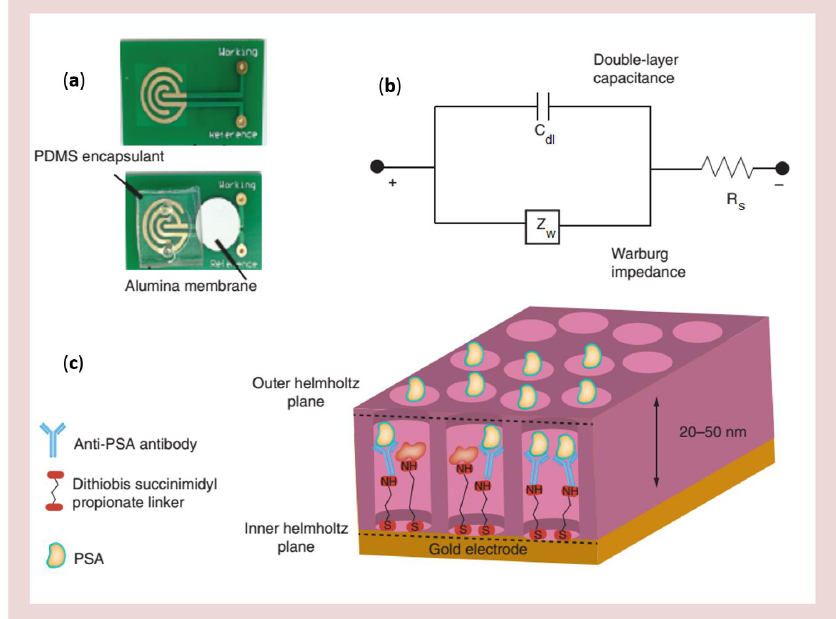
Figure 14. Electrical nanowell biosensor design, assembly and operation. Sensor device and operation ( a ) optical micrograph showing the gold microelectrodes, PDMS encapsulant and nanoporous alumina membrane ( b ) modified Randles equivalent circuit for label-free non-faradaic impedance spectroscopy and ( c ) schematic representation of binding events at the electrical double layer. PDMS: Polydimethyl siloxane; PSA: Prostate-specific antigen (reprinted with permission from